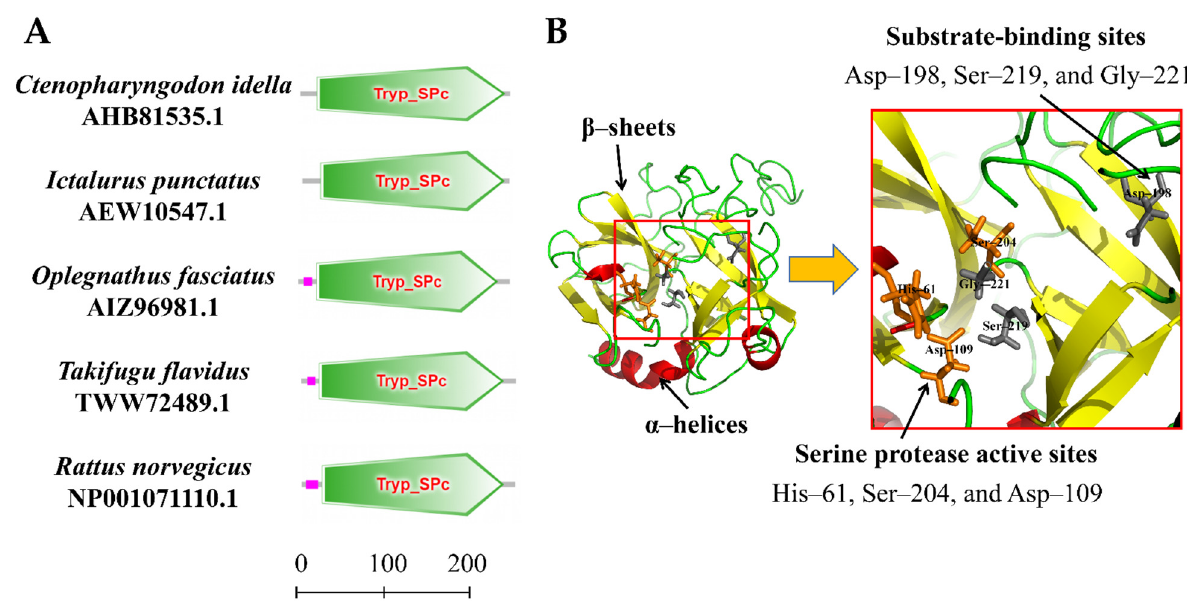
Figure 4. Protein domains and three-dimensional structure of Ci Df. ( A ) Protein domains of Dfs from Ctenopharyngodon idella , Ictalurus punctatus , Oplegnathus fasciatus , Takifugu flavidus , and Rattus norvegicus were compared. Tryp_SPc represents the trypsin-like serine protease. The scale on the bottom margin indicates amino acid number. ( B ) In the three-dimensional structure of Ci Df, the catalytic sites are colored in orange, and the substrate-binding sites in gray.